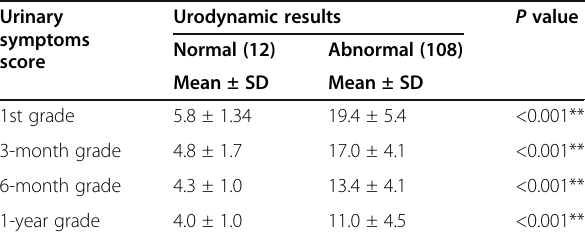
Table 3 The relationship of urinary symptoms severity through the follow-up between abnormal and normal urodynamic